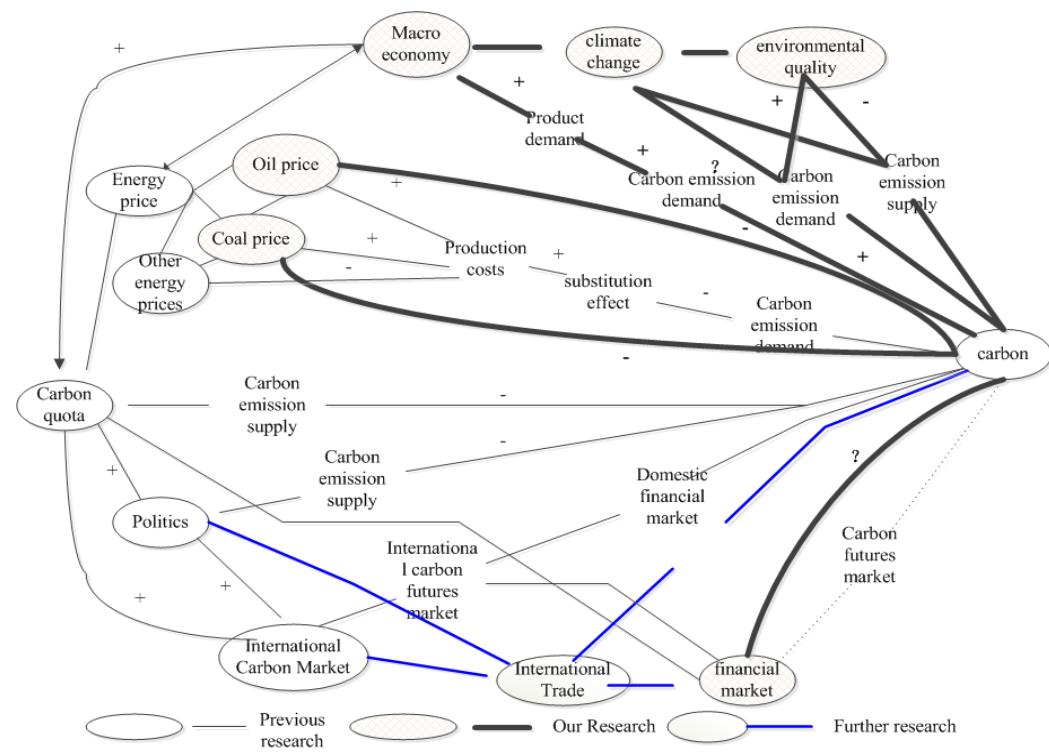
Figure 6. Effect path of carbon price drivers.